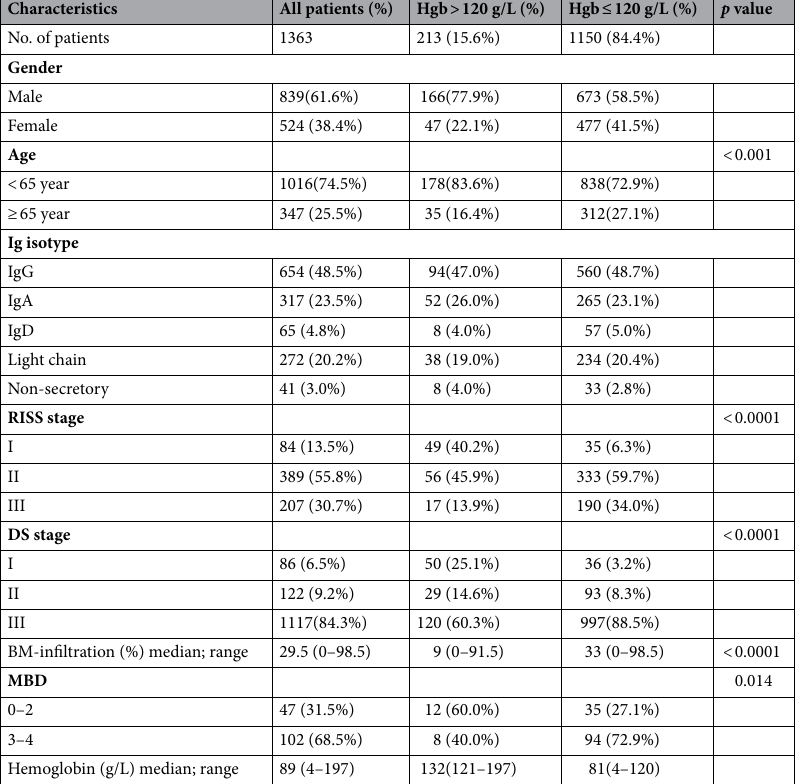
Table 1. Baseline characteristics of 1363 NDMM patients. RISS Revised international staging system, DS Durie Salmon, MBD myeloma bone